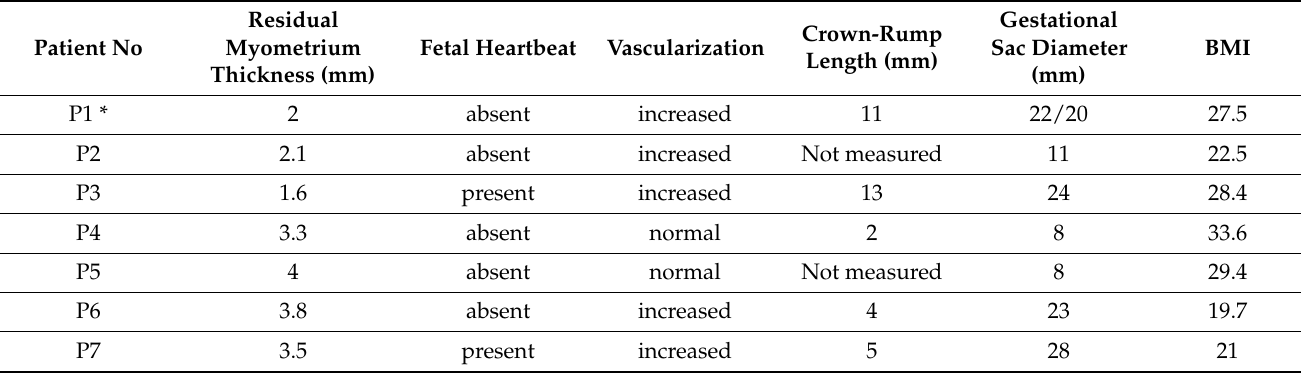
Table 2. The results of the initial ultrasound